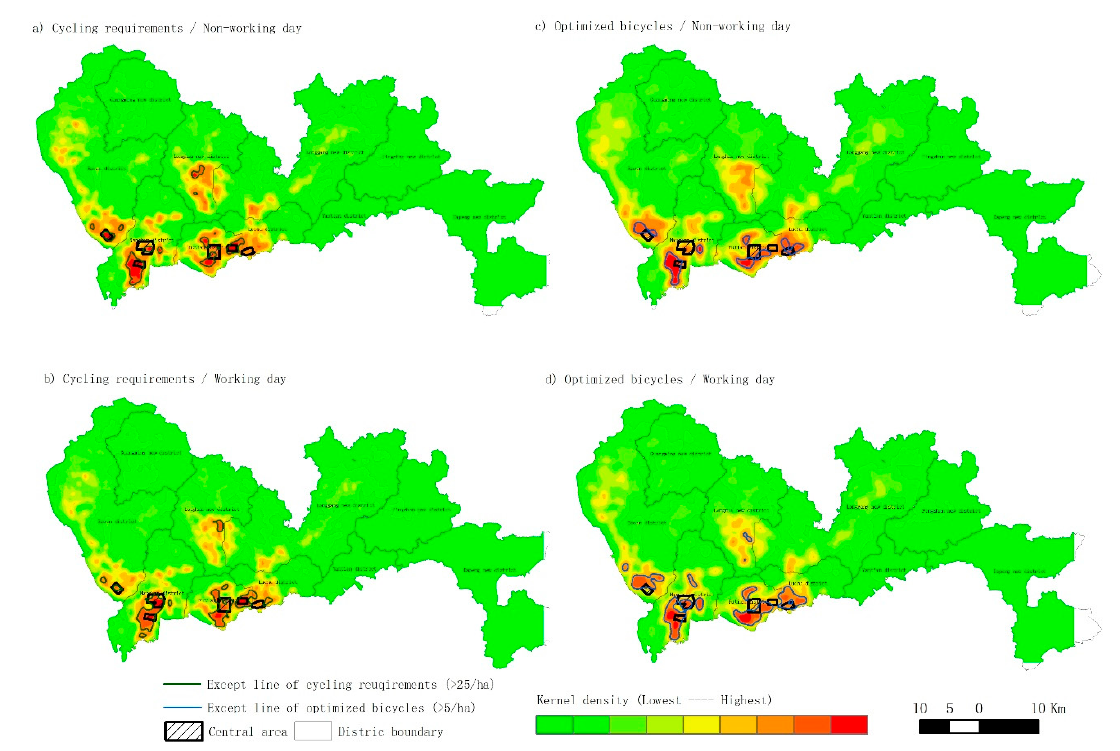
Figure 6. Spatial requirements of cycling and the spatial distribution of optimized bikes.